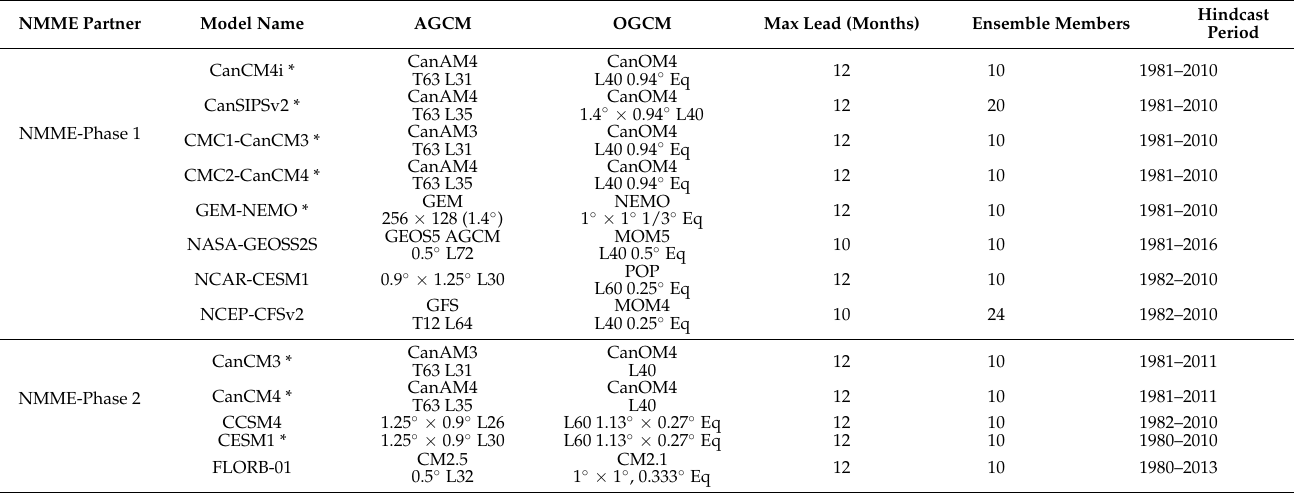
Table 1. Description of 13 NMME models used in this study. The mark of asterisk denotes the model that has provided the output of zonal wind at 850